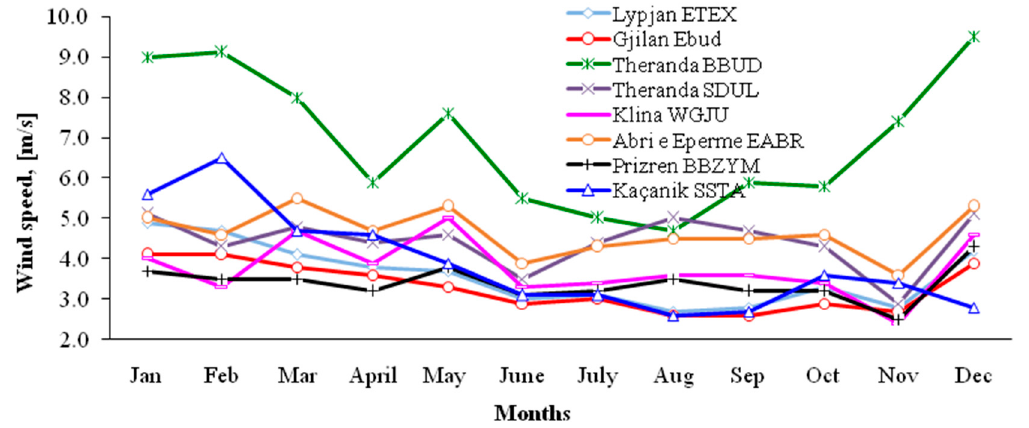
ff erent area locations in Kosovo